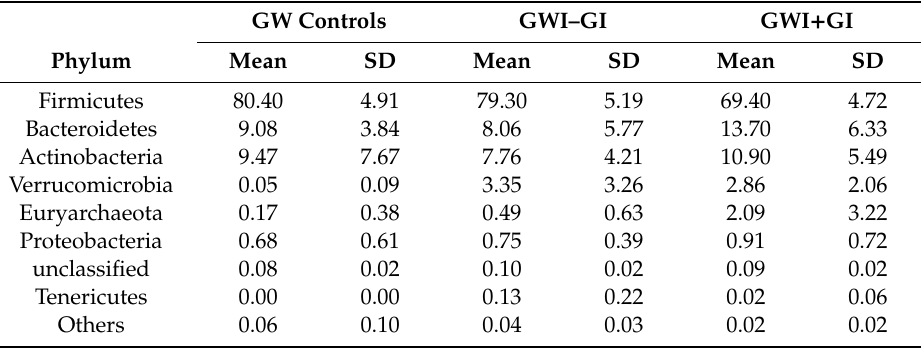
Table 4. Percent relative abundance at the Phyla Level by